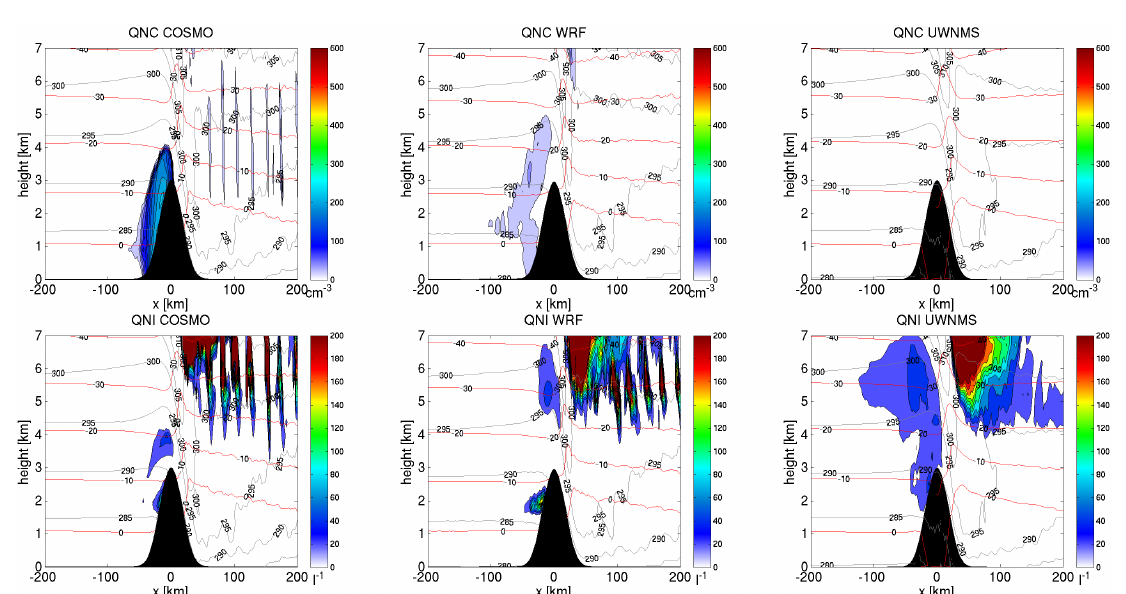
Fig. 14. Same as Fig. 4 but for simulation SIM 3